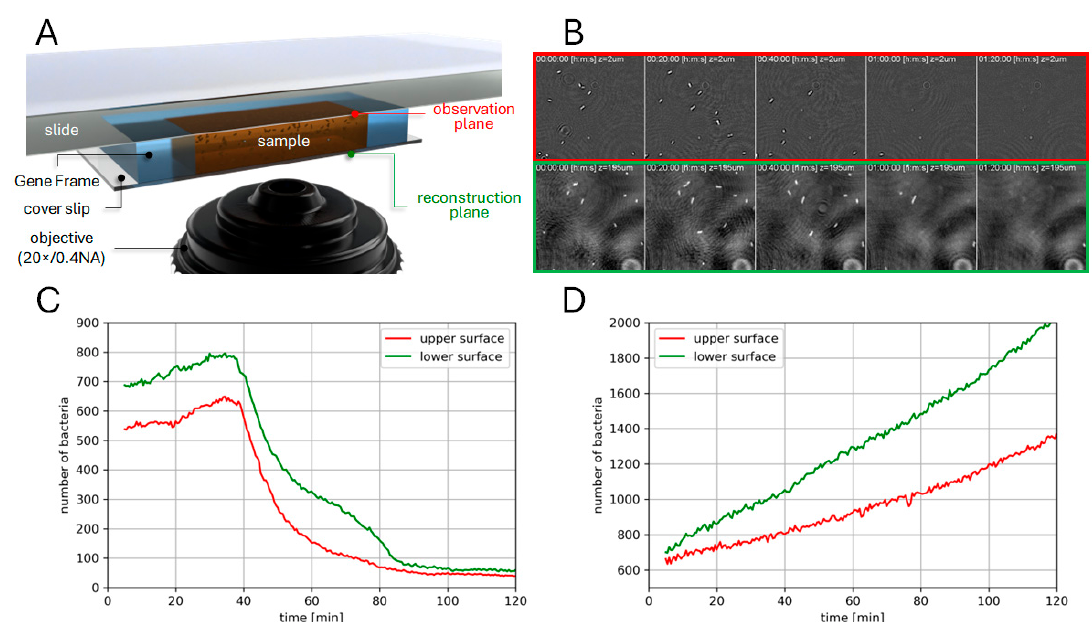
Figure 4. ( A ) Schematic of the optical setup for phase imaging of phage–bacteria interactions. The position of the glass slide was adjusted such that its upper surface was coincident with the observation plane. Images can be reconstructed in any plane within the volume enclosed by the Gene Frame, e.g., on the surface of the lower glass slide. Not to scale. ( B ) A sequence of 100 µ m × 100 µ m regions of interest extracted from the time-lapse of the observation plane (top row) and in the reconstructed image in the plane of the lower surface (bottom row). ( C ) Total number of bacteria vs. time in presence of gh-1 bacteriophages on the observation plane (red) and on the reconstructed plane (green). ( D ) Total number of bacteria vs. time (negative control without phages) on the observation plane (red) and on the reconstructed plane